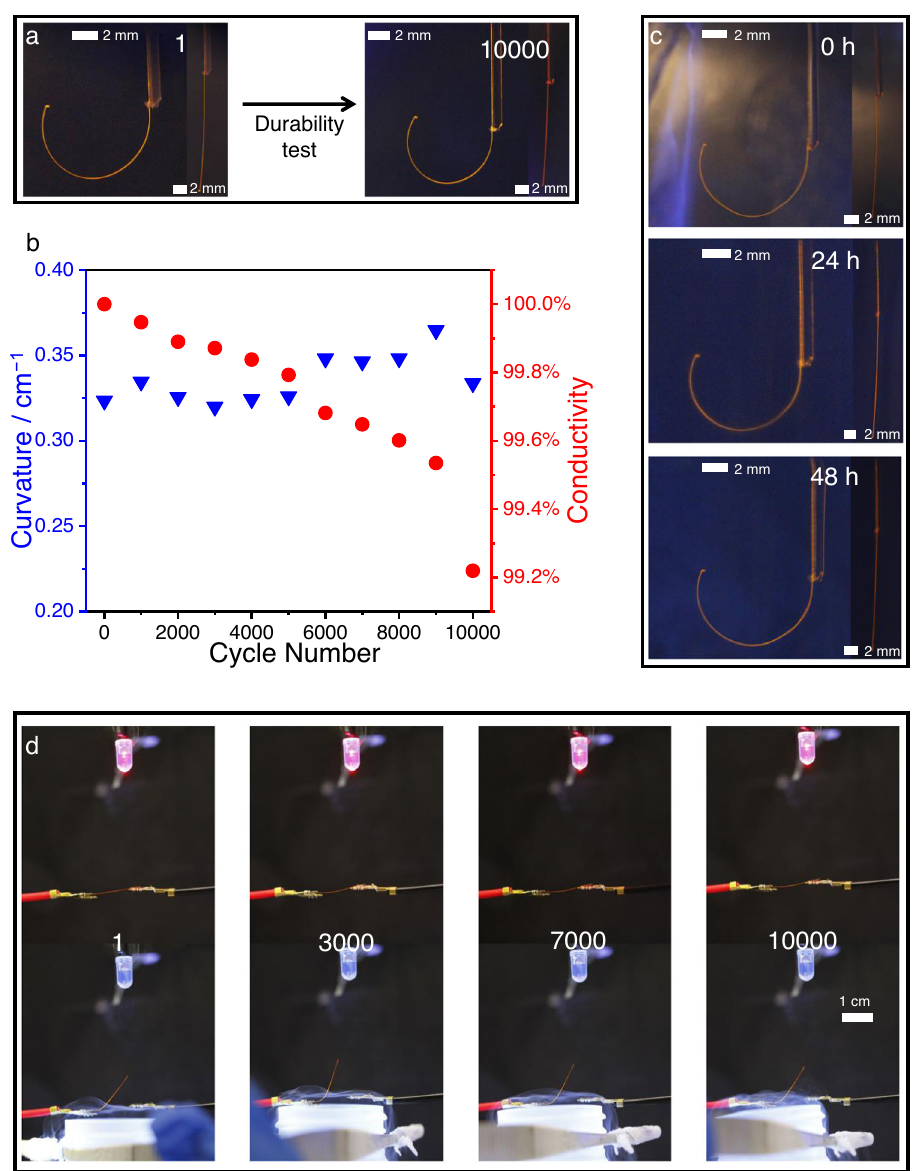
Fig. 5 | Durability upon cyclic operation. a Optical images of Au//2//P after the fi rstand10,000thcycleofbending. b CurvatureandconductivitychangeofAu//2// Pduringcyclicoperation. c OpticalimagesofAu//2//Pplacedinaliquidnitrogenfor